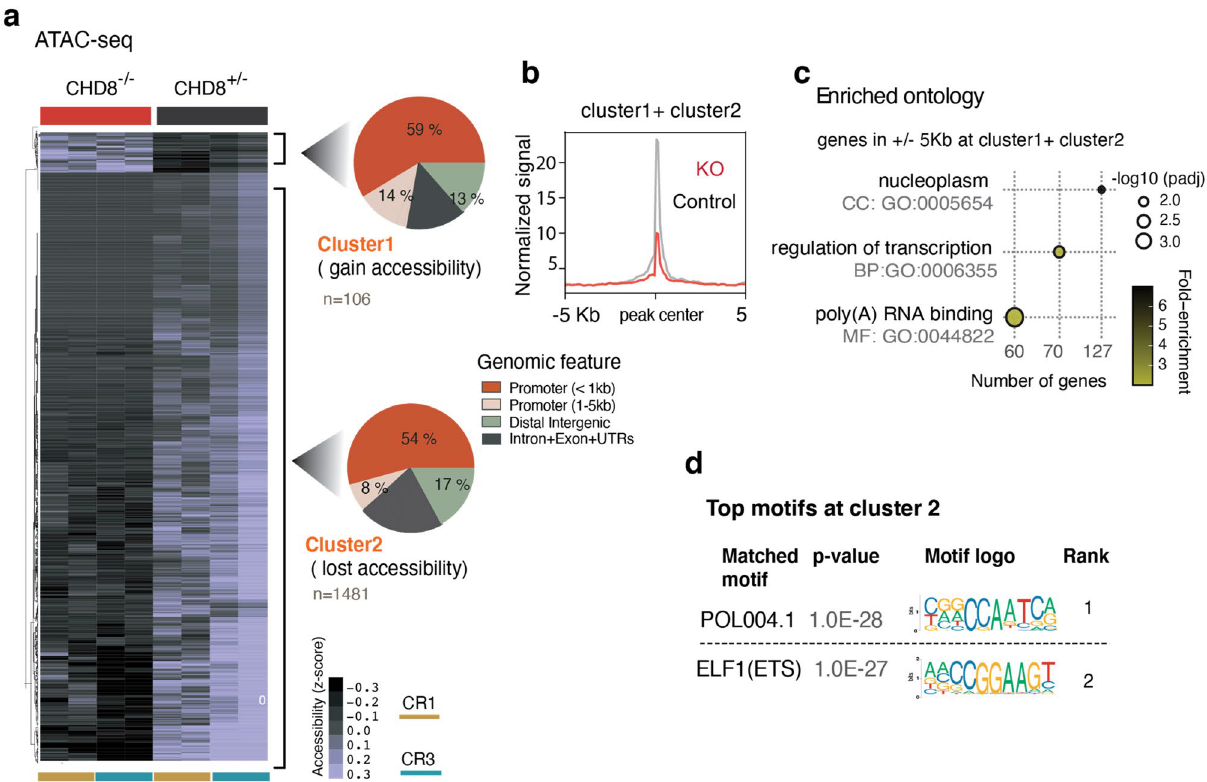
Figure 15. CHD8 globally promotes chromatin accessibility in neurons. ( a ) Heatmaps of normalized ATAC- seq signal in cKO homozygous and control neurons from a targeted ES cell line (CR1) and a targeted iPS cell line (CR3) and two technical replicates within each line. Cluster1 and Cluster 2 are separated based on unsupervised clustering analysis, which shows sites that gain or lost accessibility regions in KO and plotted the corresponding genomic annotation at each cluster. ( b ) Normalized ATAC-seq signal from aggregates of Cluster1 and Cluster2 shows KO chromatin predominantly lost accessibility. ( c ) Ontology analysis of the genes with differentially regulated ATAC-seq peaks in KO at the promoters’ vicinity (± 5 Kb TSS in Cluster1 + Cluster2). ( d ) Motif enrichment analysis in Cluster